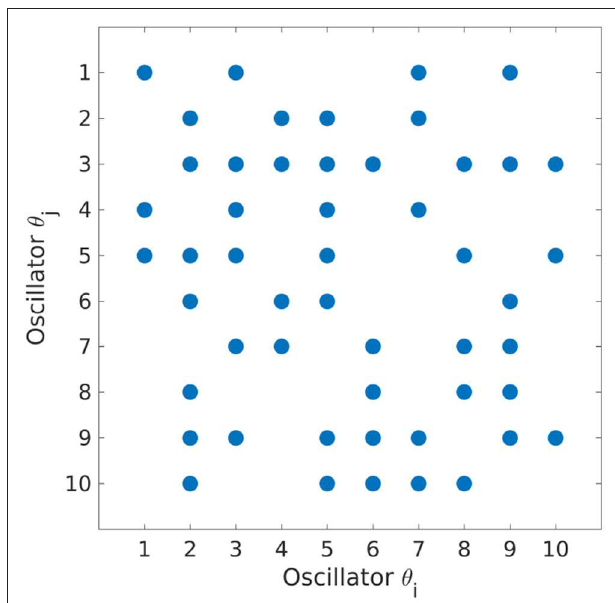
10 oscillators and K < 0. =